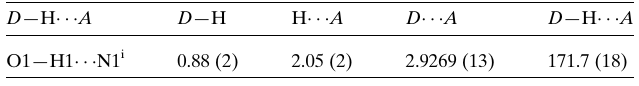
Table 1 Hydrogen-bond geometry (A˚ , (cid:2) ).